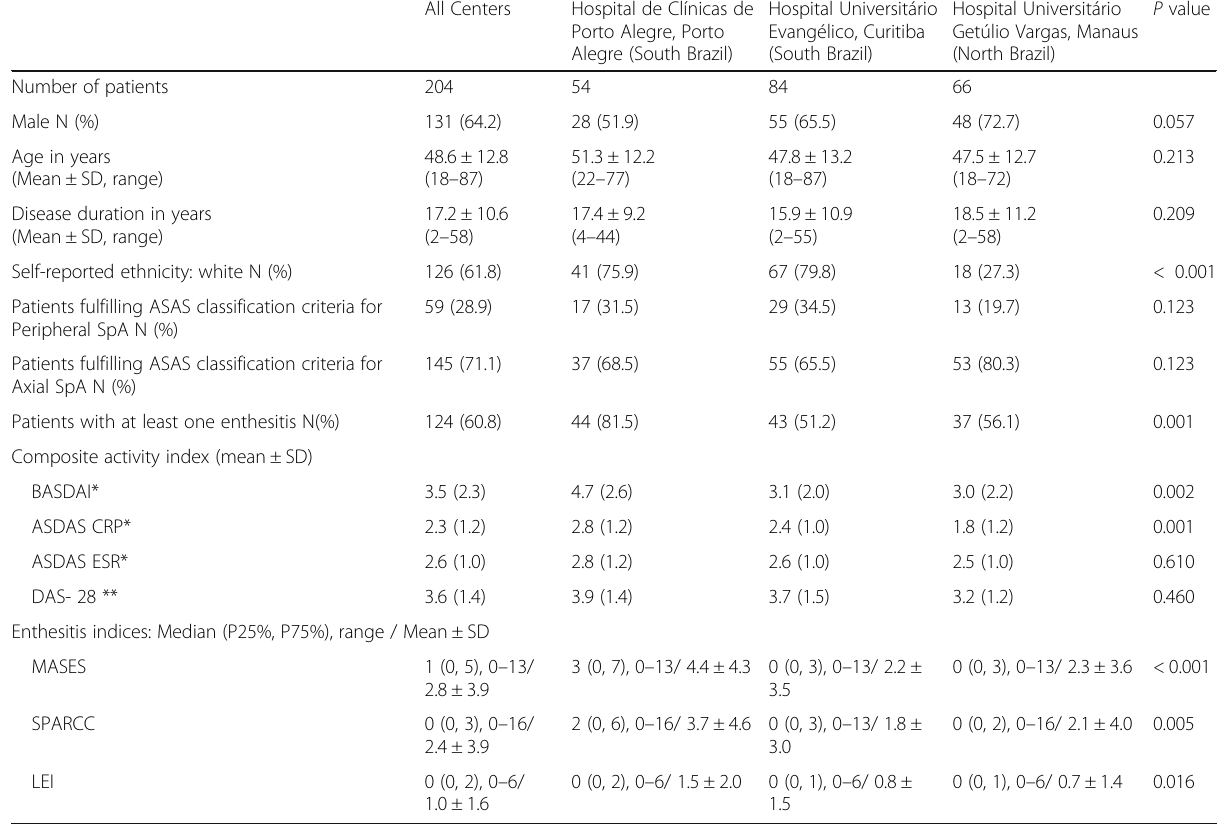
Table 1 Characteristics of the 204 patients included in the analysis